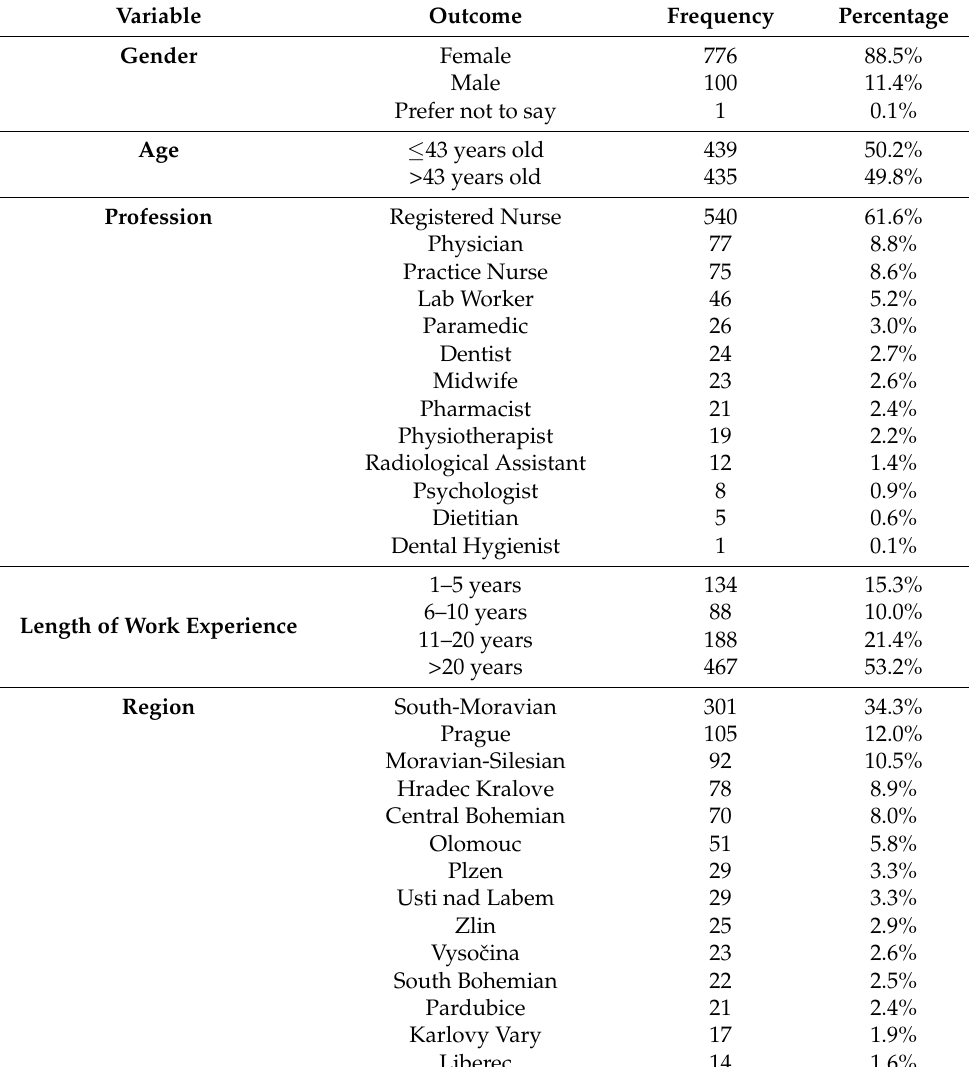
Table 2. Demographic characteristics of the Czech healthcare workers who received the Pfizer– BioNTech COVID-19 vaccine, January–February